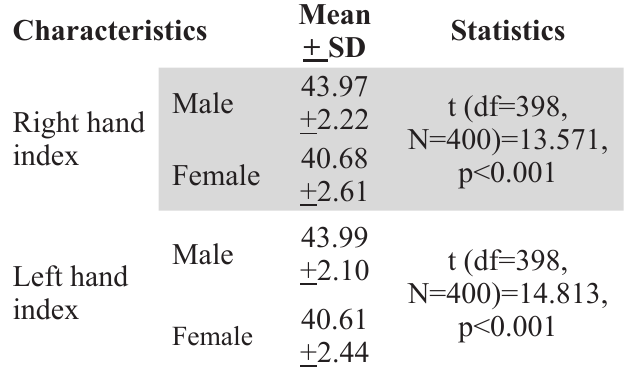
Table 2. Comparison of hand index for male and female partici- pants.